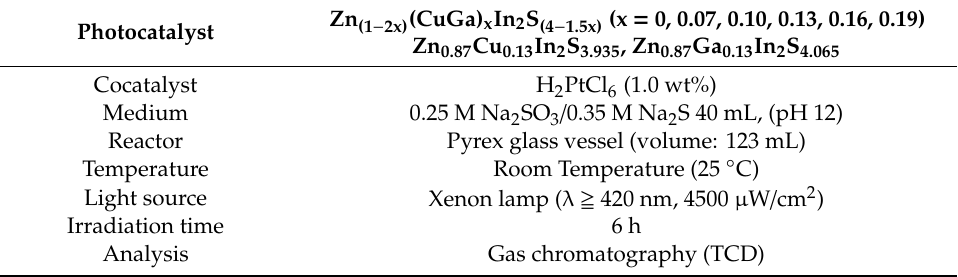
Table 1. Hydrogen generation experimental